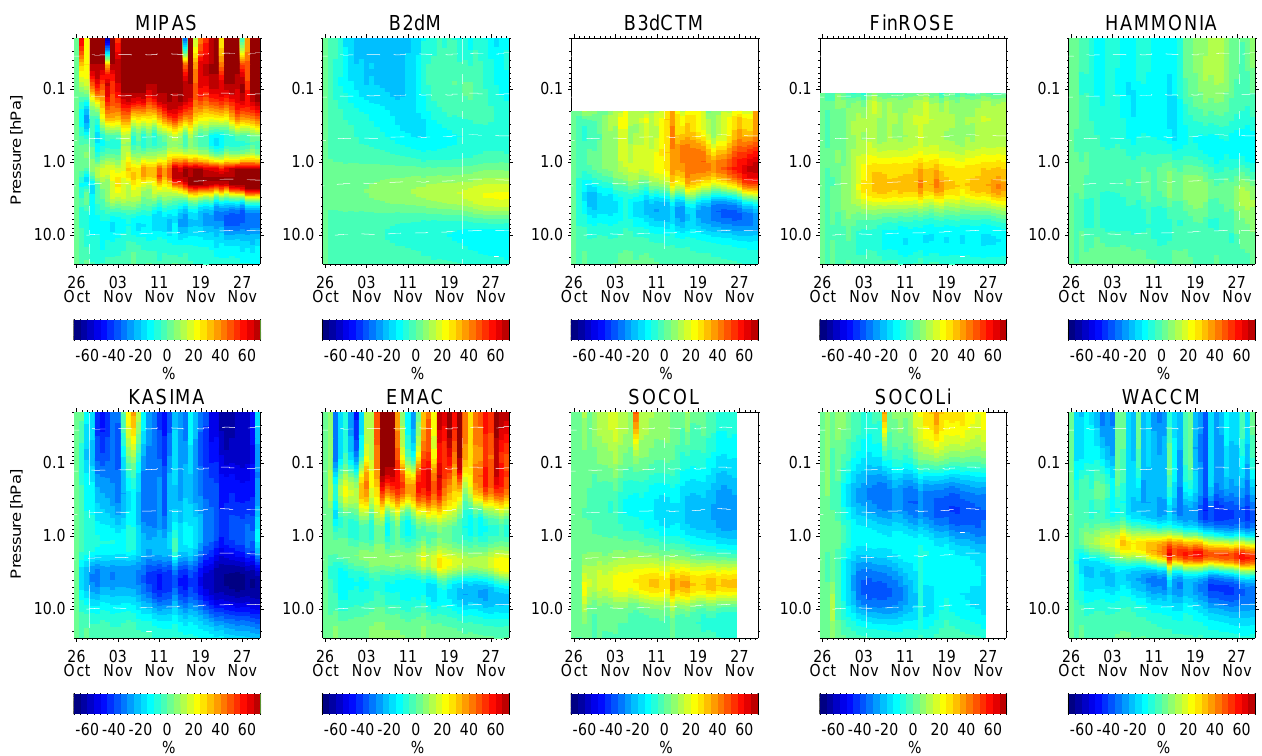
Fig. 10. Temporal evolution of CH 4 changes with respect to 26 October 2003 in MIPAS observations and model simulations averaged over 70–90 ◦ N.